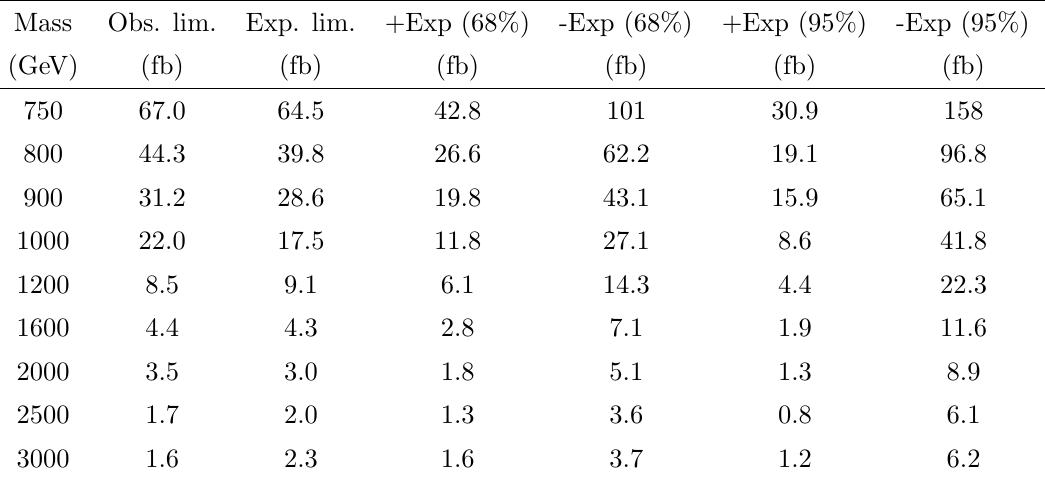
Table 5 . The observed and expected upper limits on the products of the cross sections and branching fraction (cid:27) (pp ! X) B (X ! HH ! bbbb) for a radion from the combination of the fully- merged and semi-resolved channels (where the events used in the fully-merged analysis are not considered in the semi-resolved analysis). Results above 1600 GeV for the radion are taken directly from the fully-merged analysis [39].